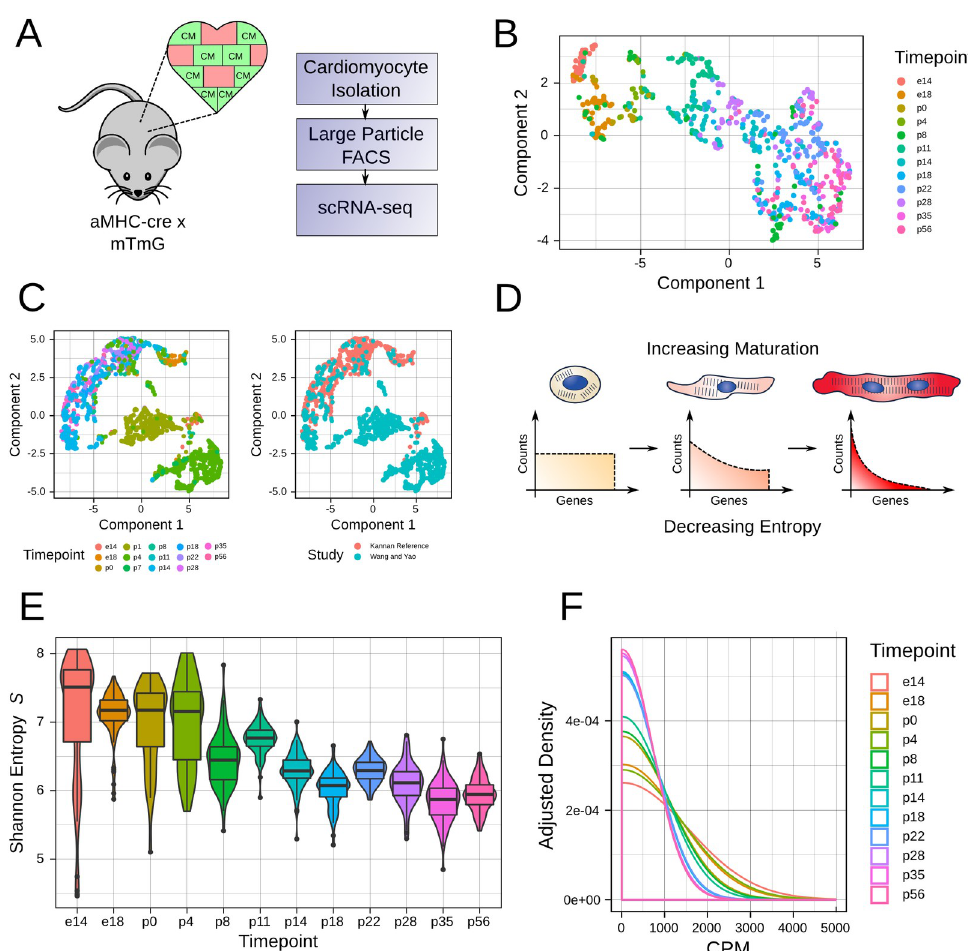
Fig 1. scRNA-seq constructs a reference for CM maturation. A. Mouse model used to generate perinatal maturation reference scRNA-seq library. In the aMHC-cre x mTmG mouse, CMs are labeled by GFP. This image was obtained and modified from “Brown Mouse Lab” by SVG-Clipart.com under a CC BY 4.0 license. B. UMAP dimensionality reduction (via Monocle 3) for the maturation reference. C. mnnCorrect-based integration of Wang and Yao et al. dataset with reference dataset. D . Our model for changes in gene distribution over CM maturation. As CMs undergo the maturation process, they transition from a broad gene distribution (characterised by high entropy) to a more narrow distribution (characterised by low entropy). E . Shannon Entropy S computed for each timepoint in the maturation reference dataset. F. Smoothed density estimates for genes expressed at 0–5000 counts per million (CPM) for each timepoint in the maturation reference